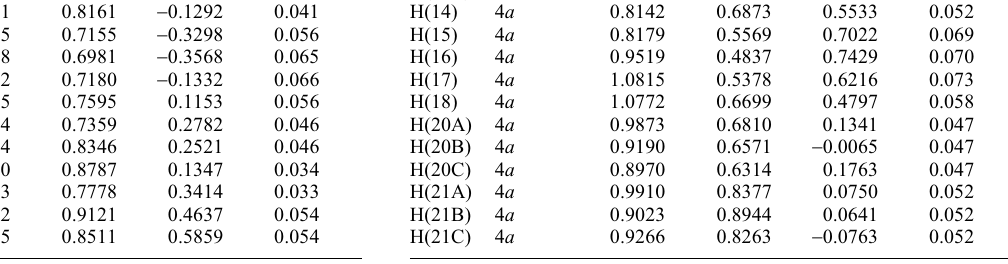
Table 3. Atomic coordinates and displacement parameters (in Å 2 ) .